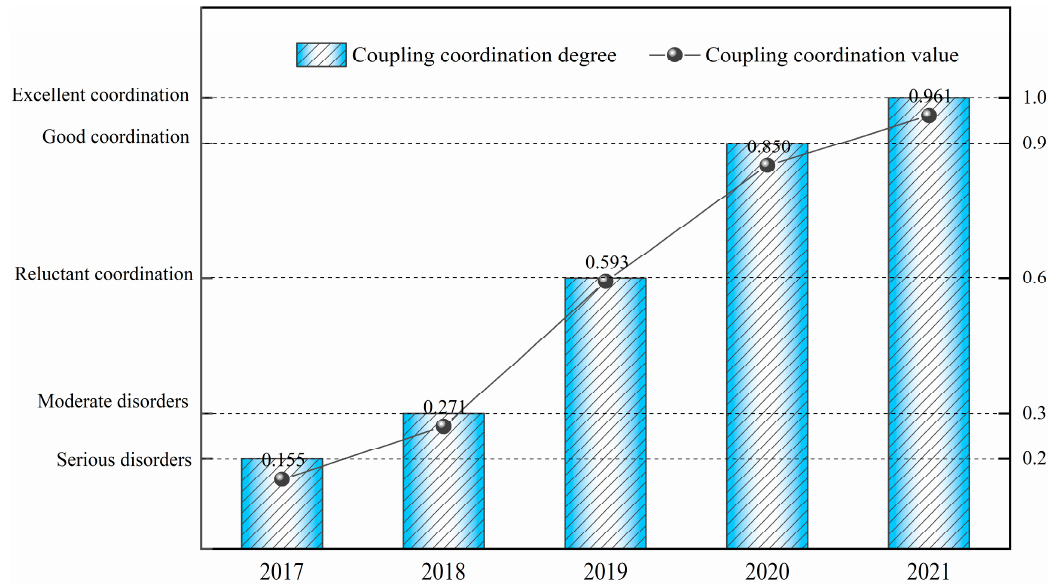
Figure 6. Change Trend of Coupling Co-scheduling in 2017–2021.